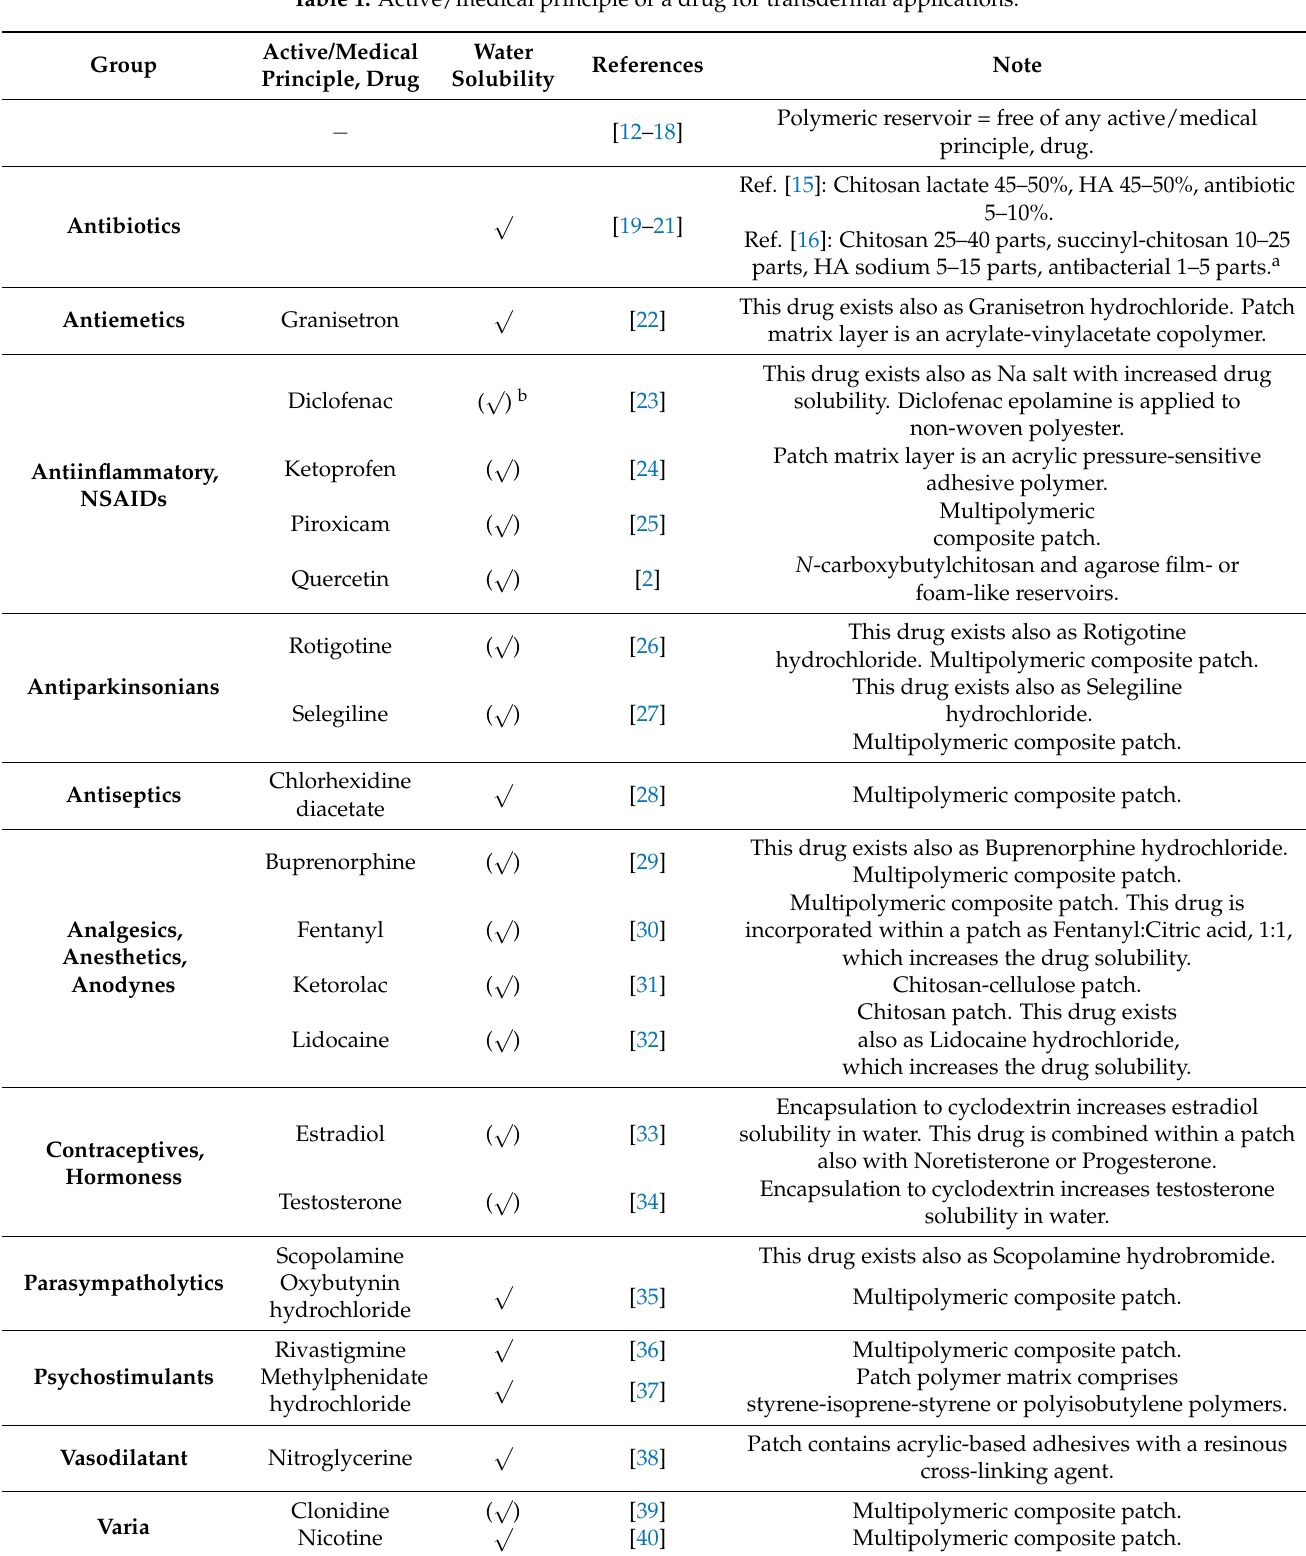
Table 1. Active/medical principle or a drug for transdermal